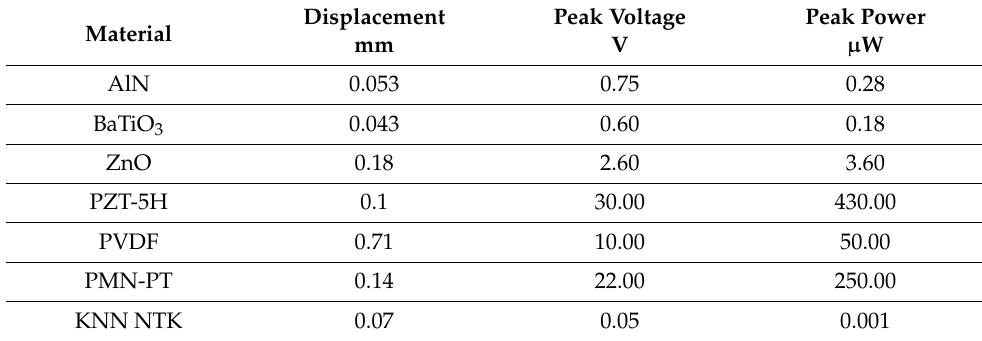
Table 3. The axial loading performance of piezoelectric materials.